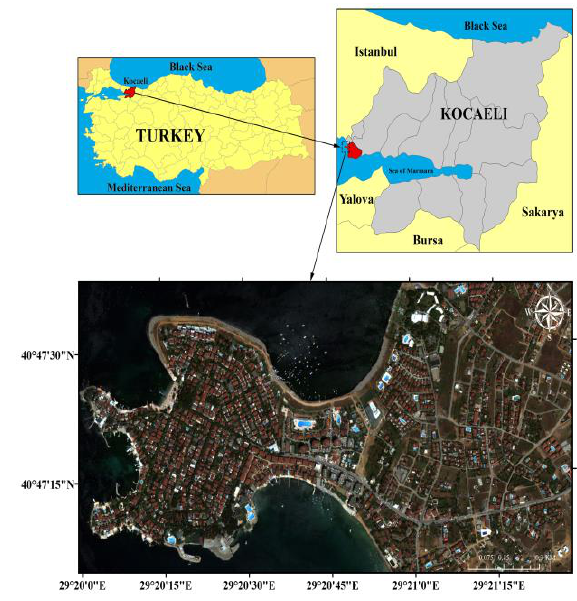
Figure 1. The location of study area